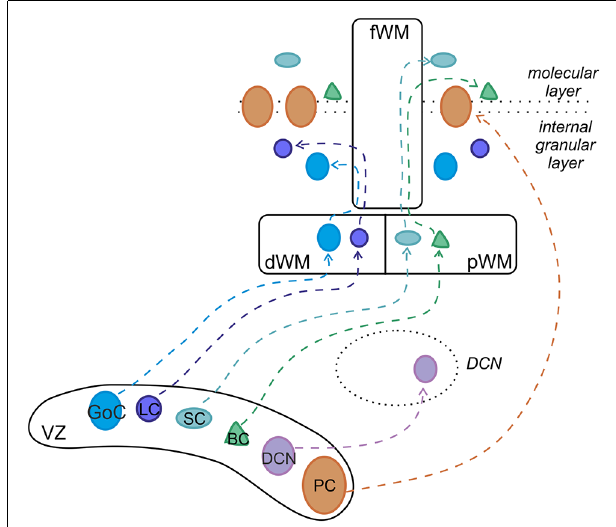
FIGURE 2 | Developmental origin of cerebellar GABAergic neurons. Ptf1-a -positive progenitors in the ventricular zone (VZ) generate the entire repertory of GABAergic projection neurons and interneurons through different neurogenic strategies. While projection neurons proliferate and become specified within the VZ, cortical interneurons derive from precursors that originate in the VZ but continue their neurogenic activity in the pWM or dWM, where they acquire mature identities under the influence of specific extracellular cues. Afterward, the interneurons move to their final destination through the folial white matter (fWM). pWM, prospective white matter; dWM, deep white matter; fWM, folial white matter; DCN, deep cerebellar nuclei; PC, Purkinje cell; BC, basket cell; SC, stellate cell; LC, Lugaro cell; GoC, Golgi cell. Modified from Leto et al.